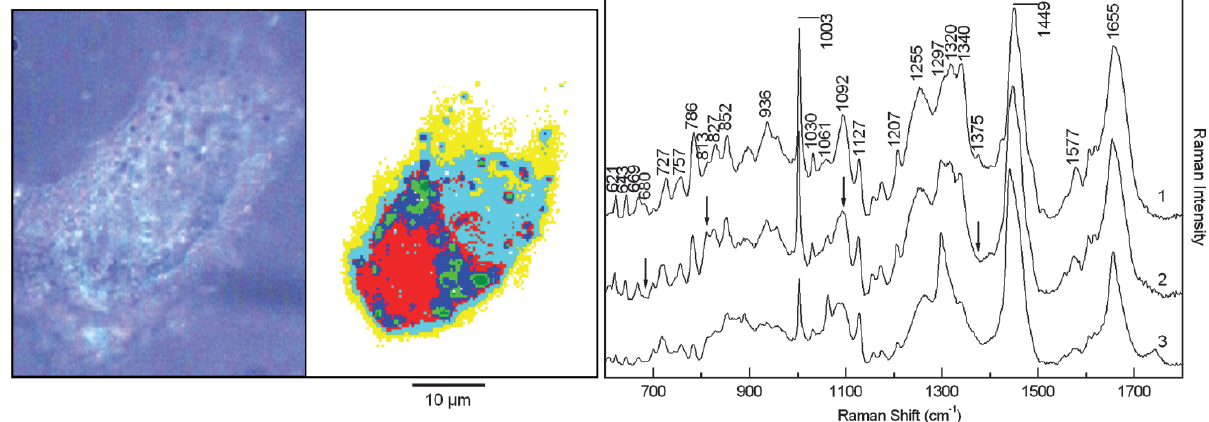
Figure 3. Photomicrograph of formalin-fixed lung fibroblast cell in buffer (left), Raman image after segmentation by cluster analysis (middle), Raman spectra (right) representing the nucleus (trace 1: red cluster), the cytoplasm (trace 2: cyan cluster) and lipid vesicles (trace 3: green cluster). © The Royal Society of